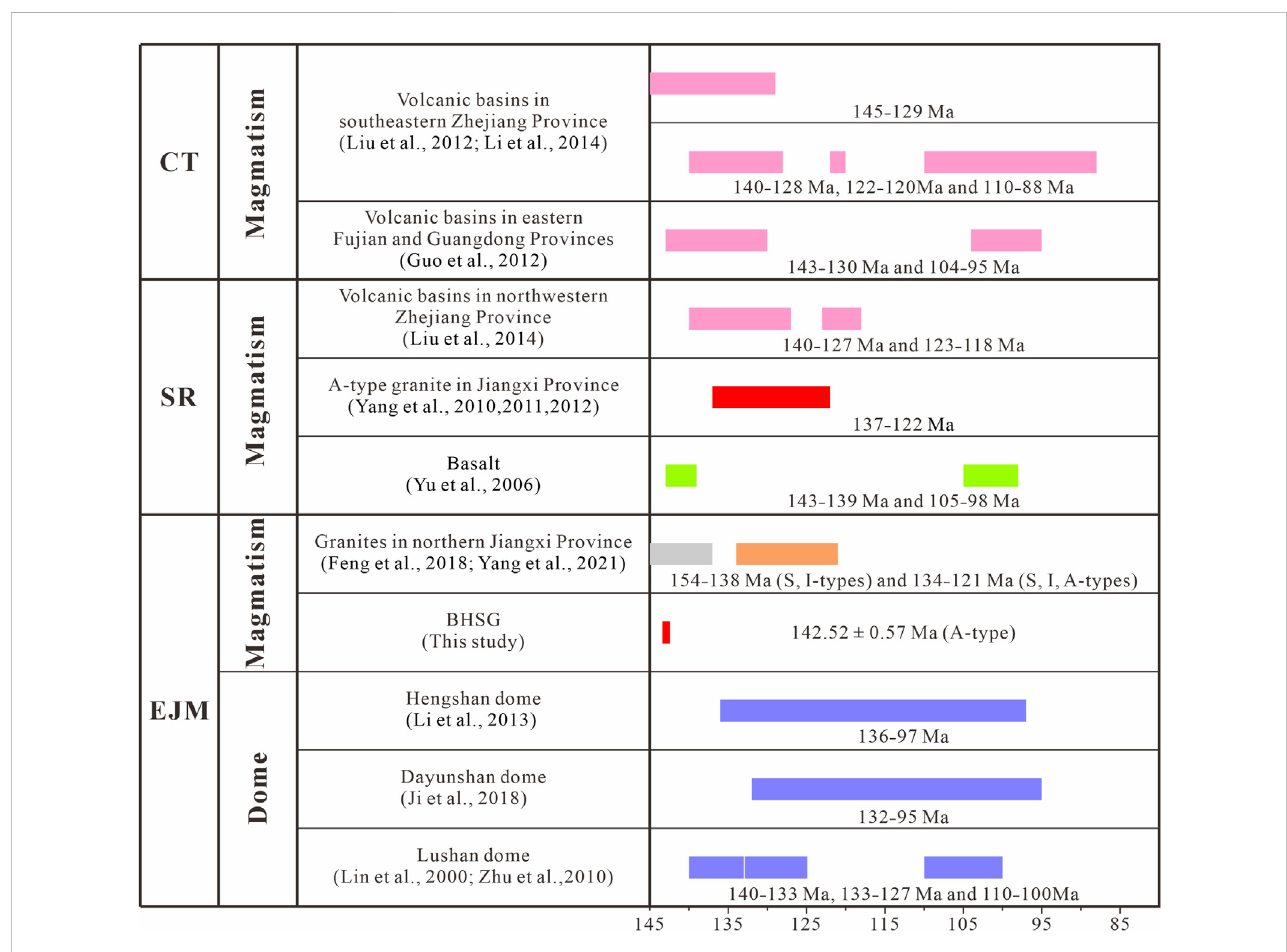
FIGURE 15 Diagram comparing the duration of extension-related geological records in different terranes of the SCB. Abbreviations: CT, coastal terrane, SR, Shi- Hang Rift, EJM, eastern Jiangnan